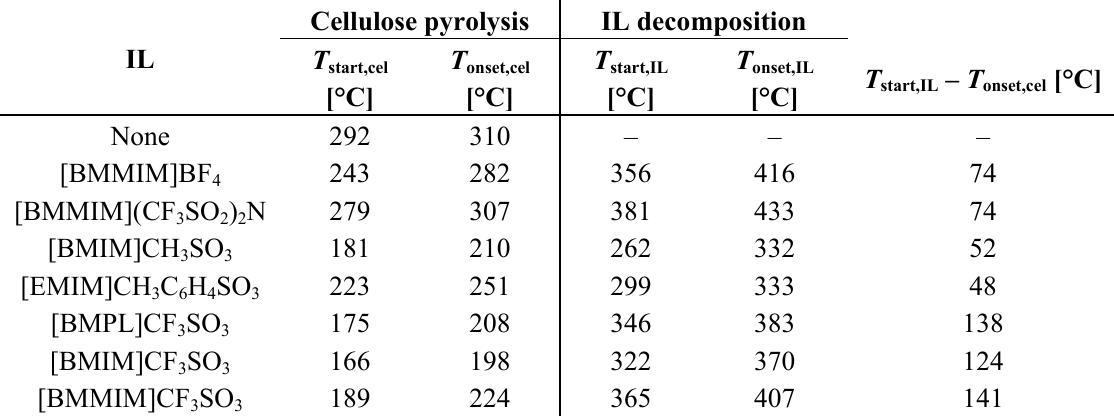
Table 1. Start and onset temperatures for cellulose pyrolysis and IL decomposition. Cellulose pyrolysis IL decomposition IL T T T T start,cel onset,cel start,IL onset,IL T – T [°C] start,IL onset,cel [°C] [°C] [°C] [°C] None 292 310 – – – [BMMIM]BF 243 282 356 416 74 4 279 307 74 181 210 262 52 138 124 189 224 365 407